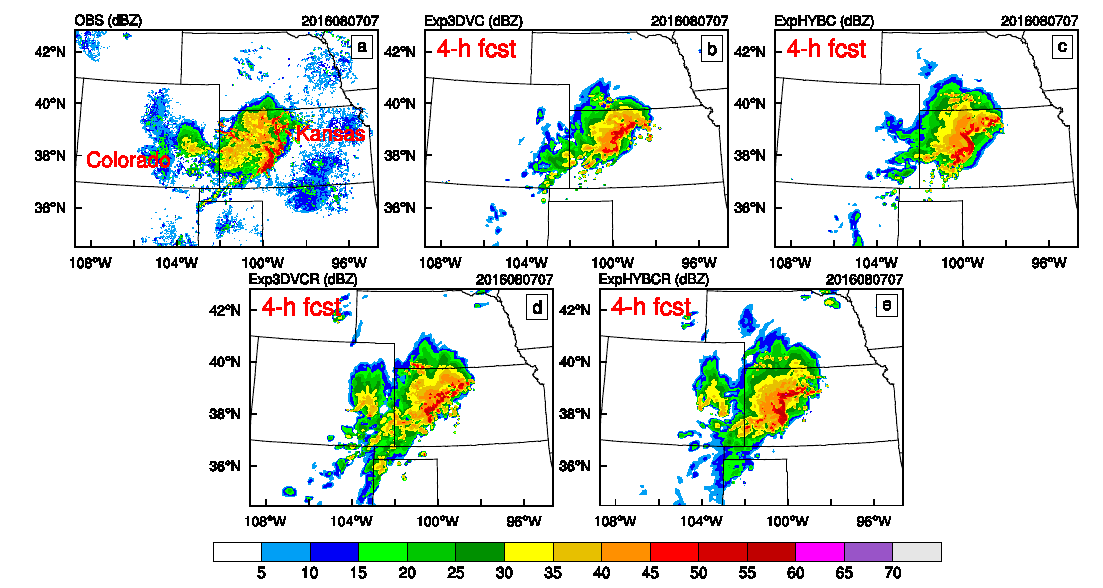
Figure 13. Composite reflectivity (unit: dB Z ) of: observation ( a ); Exp3DVC ( b ); ExpHYBC ( c ); Exp3DVCR ( d ); and ExpHYBCR ( e ) of the convective system at 07:00 UTC on 7 August 2016 (initialized at 03:00 UTC on 7 August 2016).